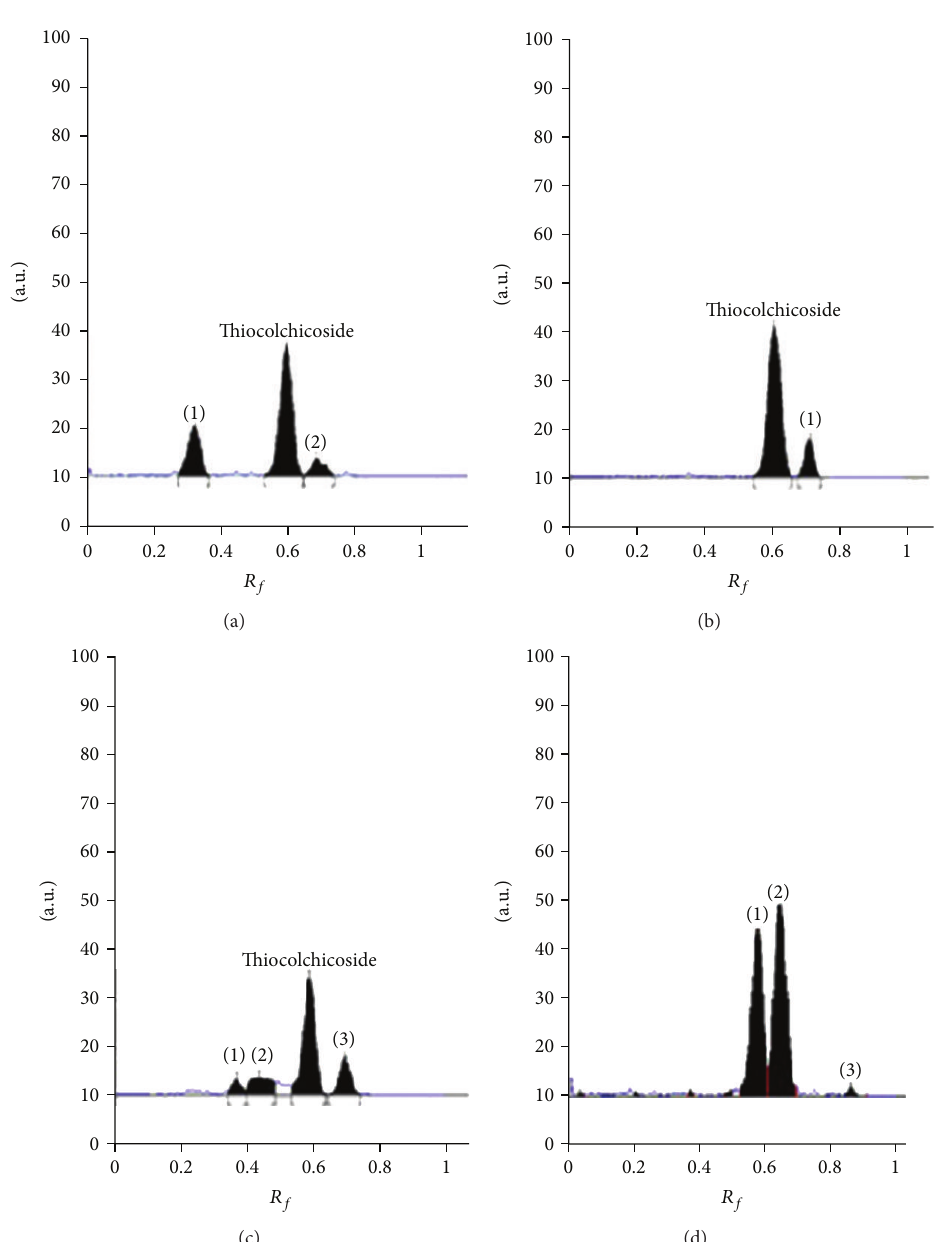
Figure 5: RP-HPTLC chromatograms obtained from thiocolchicoside degraded by (a) acidic hydrolysis (1MHCl), (b) alkaline hydrolysis (0.5MNaOH), (c) oxidative stress (1%v/v H 2 O 2 ), and (d) oxidative stress (3%v/v H 2 O 2